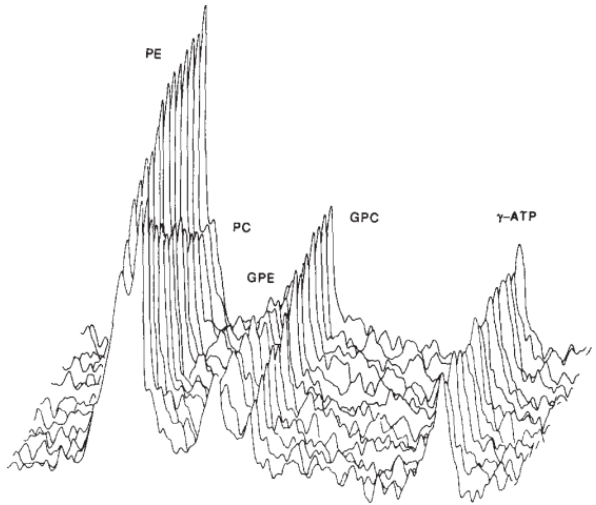
Figure 8. Plot of number of hits vs. year for a search of “phospho- choline and cancer” using the Scifinder (CAS) search engine, with 1,485 hits at